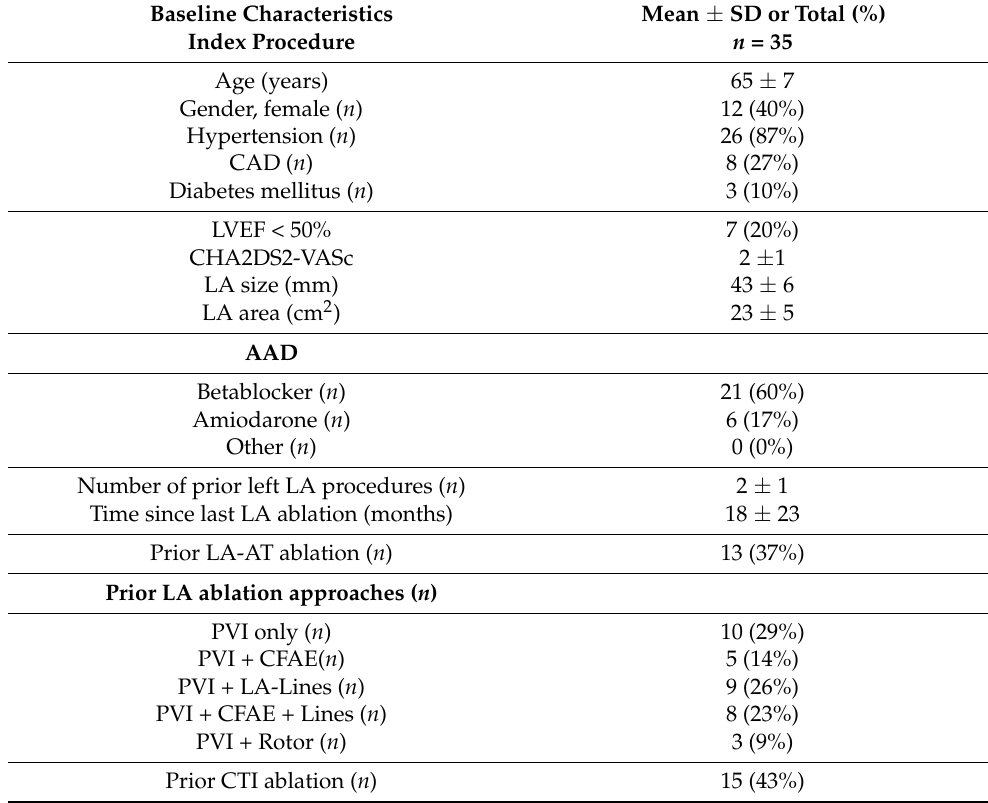
Table 1. Baseline